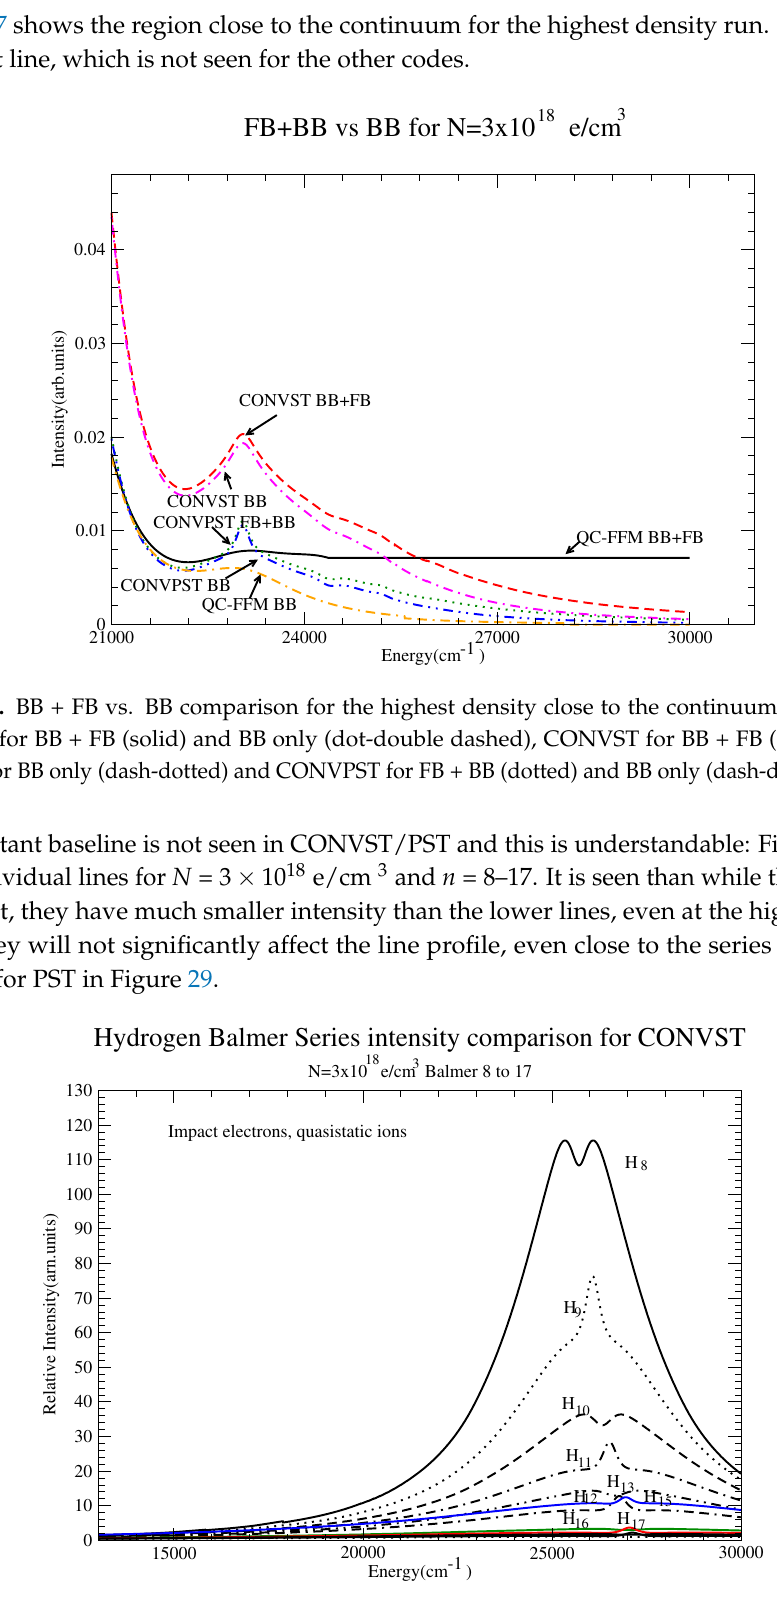
Figure 28. Intensity comparison for Balmer 8 to Balmer 17 at the highest density. Shown are CONVST profiles for H 8 (solid black), H 9 (dotted), H 10 (dashed), H 11 (dash-dotted), H 12 (dash-double dotted), H 13 (dot double dashed), H 15 (solid blue), H 16 (solid green) and H 17 (solid